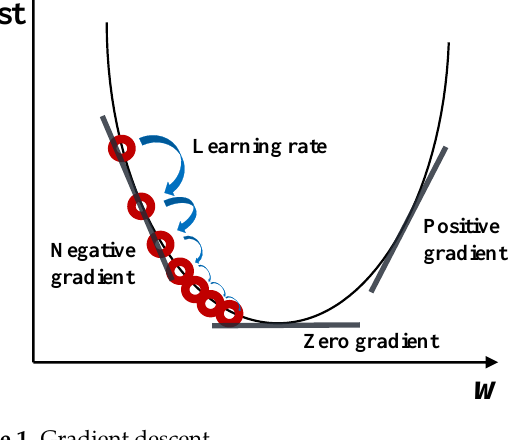
Figure 1. Gradient descent.